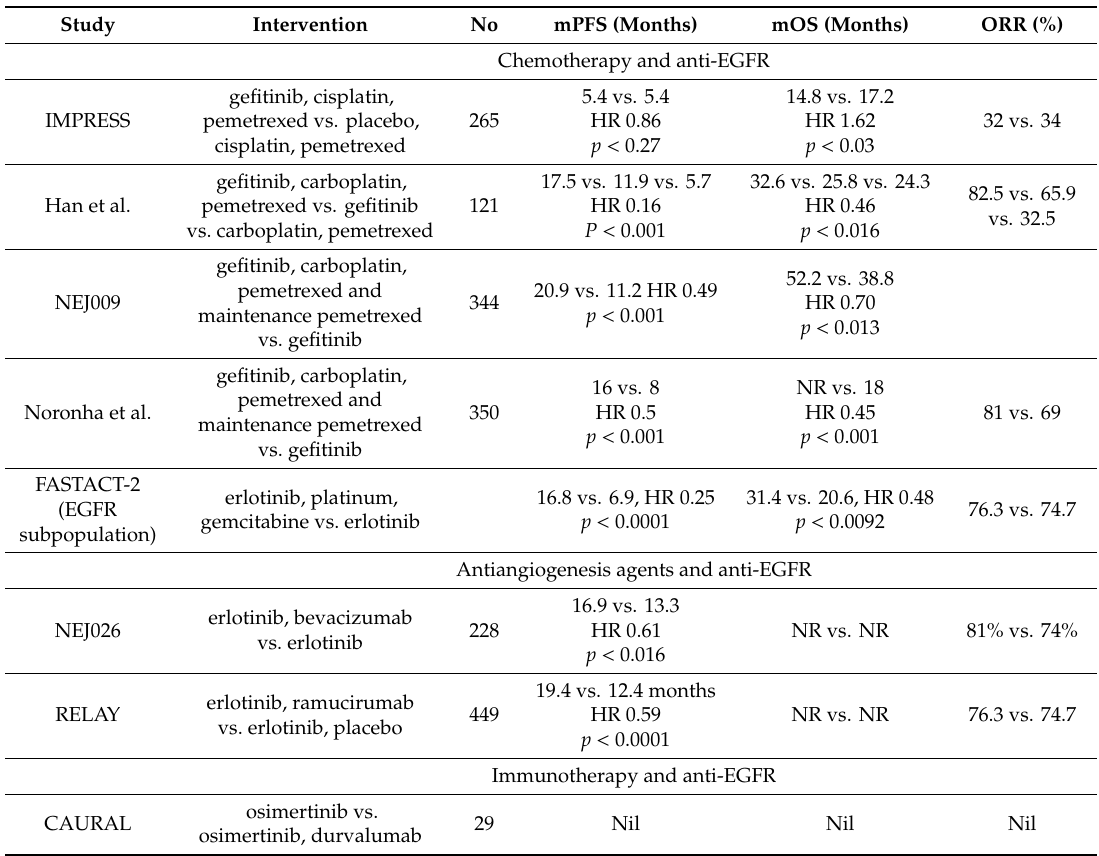
Table 3. Results of phase III trials comparing EGFR TKIs in combination with EGFR TKI alone. OS, overall